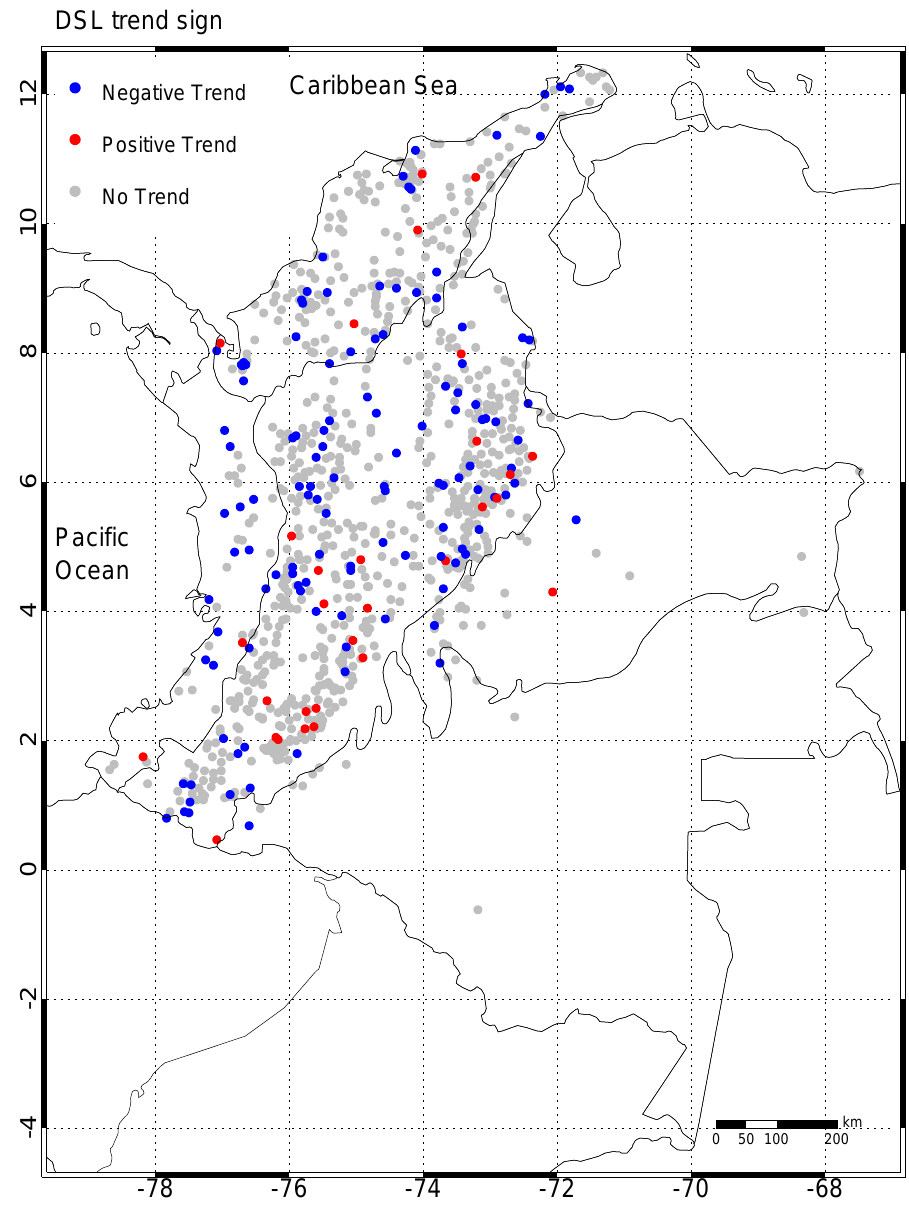
Figure 6. Map of the trend sign for DSL for rain gauge base dataset. Non-significant trends are plotted in